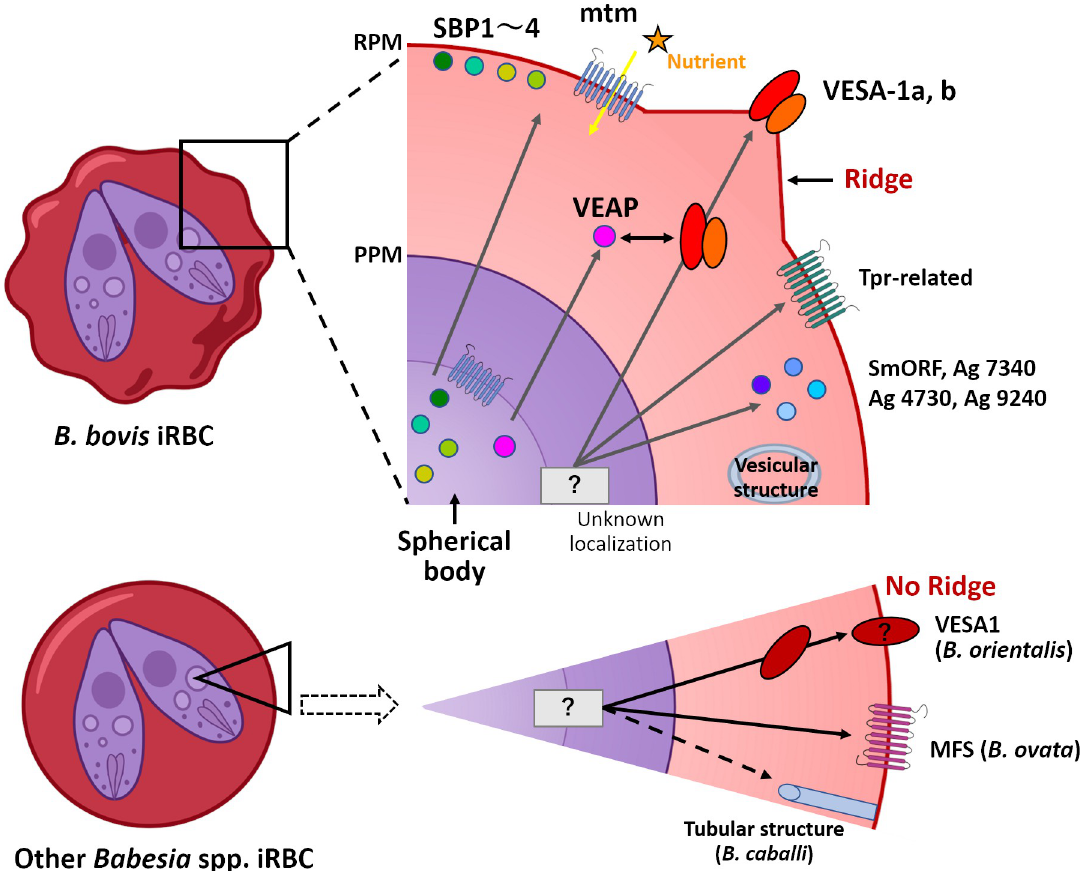
Fig 3. Babesia iRBC. Babesia parasites export numerous proteins to remodel the host RBC using secretory pathway. Several of these proteins are routed through spherical bodies, while others are either directly exported to RBC or deposited in unknown secretory organelles. B . bovis produces ridges on the surface of iRBCs to express VESA1 that mediates sequestration and immune evasion. Of spherical body proteins, SBP1, SBP2, SBP3, and SBP4 are associated with the RBC membrane; VEAP is released to the RBC cytoplasm and is essential for parasite growth and VESA1 export; mtm integrates into the RBC membrane and is likely responsible for nutrient uptake. Vesicular structures in the RBC are produced following parasite invasion that might have a role in protein export. Regarding other Babesia spp., VESA1 expression in iRBC was shown for B . orientalis and MFS export to RBC for B . ovata , though their functions remain to be determined. iRBC, infected red blood cell; mtm, multi-transmembrane protein; PPM, parasite plasma membrane; RPM, RBC plasma membrane; SBP1, spherical body protein 1; SmORF, Small Open Reading Frame protein; VEAP, VESA1-export associated protein; VESA1, variant erythrocyte surface antigen 1.